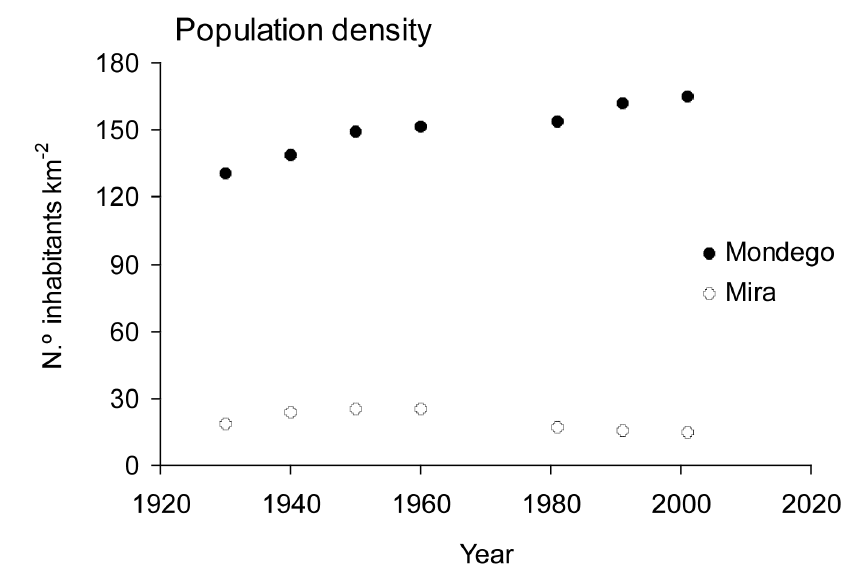
Fig. 3. Data on population density in the Mondego (Figueira da Foz Municipality) and Mira (Odemira Municipality) estuarine watersheds for the 1930–2001